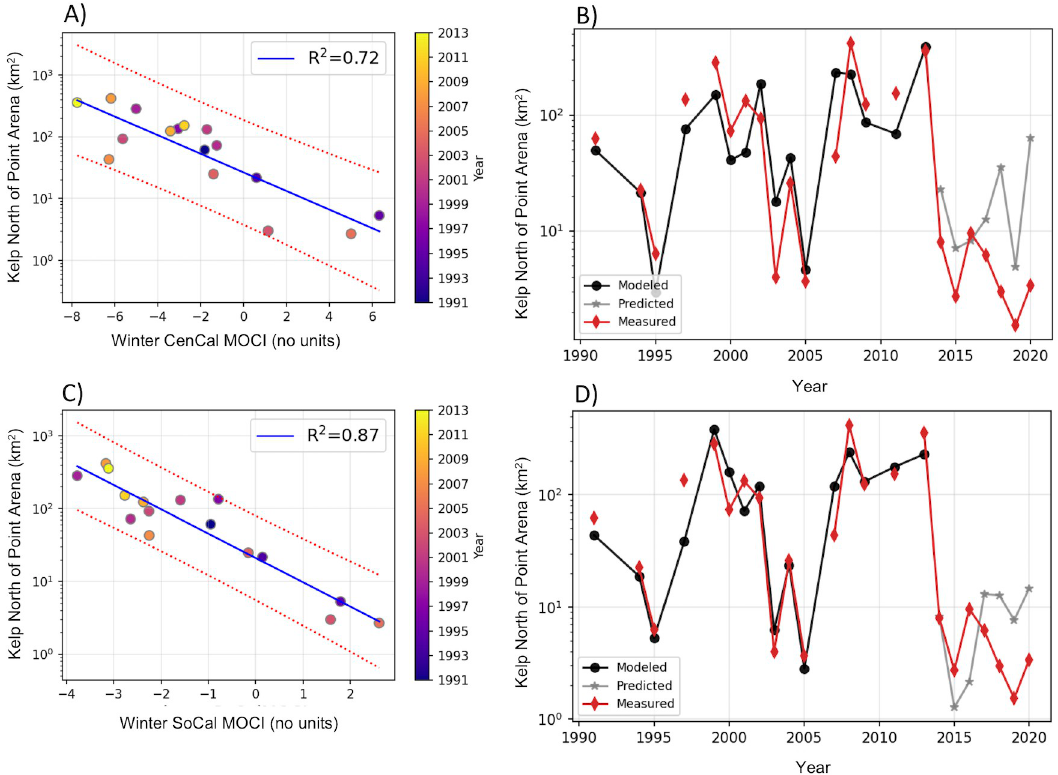
Fig 2. Linear regression between canopy coverage north of Point Arena and MOCI. (A) Linear regression between central California MOCI (CenCal MOCI) and kelp canopy extent north of Point Arena, 1991–2013, red-dotted lines indicate the confident intervals; R 2 indicates the explained variance and the color indicates the year. (B) Time series of summer kelp canopy extent north of Point Arena: measured data are in red, modeled pre-collapse data are black, and predicted data for collapsed years are shown in grey asterisks ( � ). Modeled and predicted kelp uses the linear regression in (A). (C) Same as (A) but for winter southern California MOCI (SoCal MOCI). (D) Same as (B) but model and predicted data used the linear regression with southern California MOCI shown in (C). Regressions details are in Table